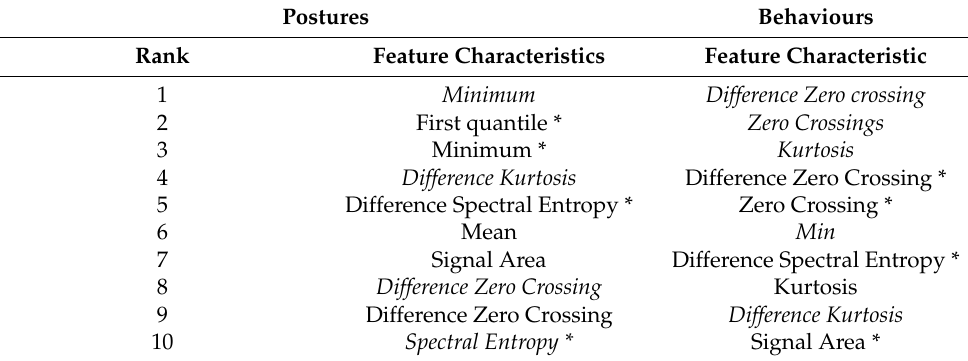
Table 2. Top 10 ranked features using the ReliefF algorithm for both postures and behaviours. Italics have been used for gyroscope difference based features to differentiate them from acceleration difference based features. Frequency domain-based features can be differentiated from time domain features by the presence of an asterisk (*).